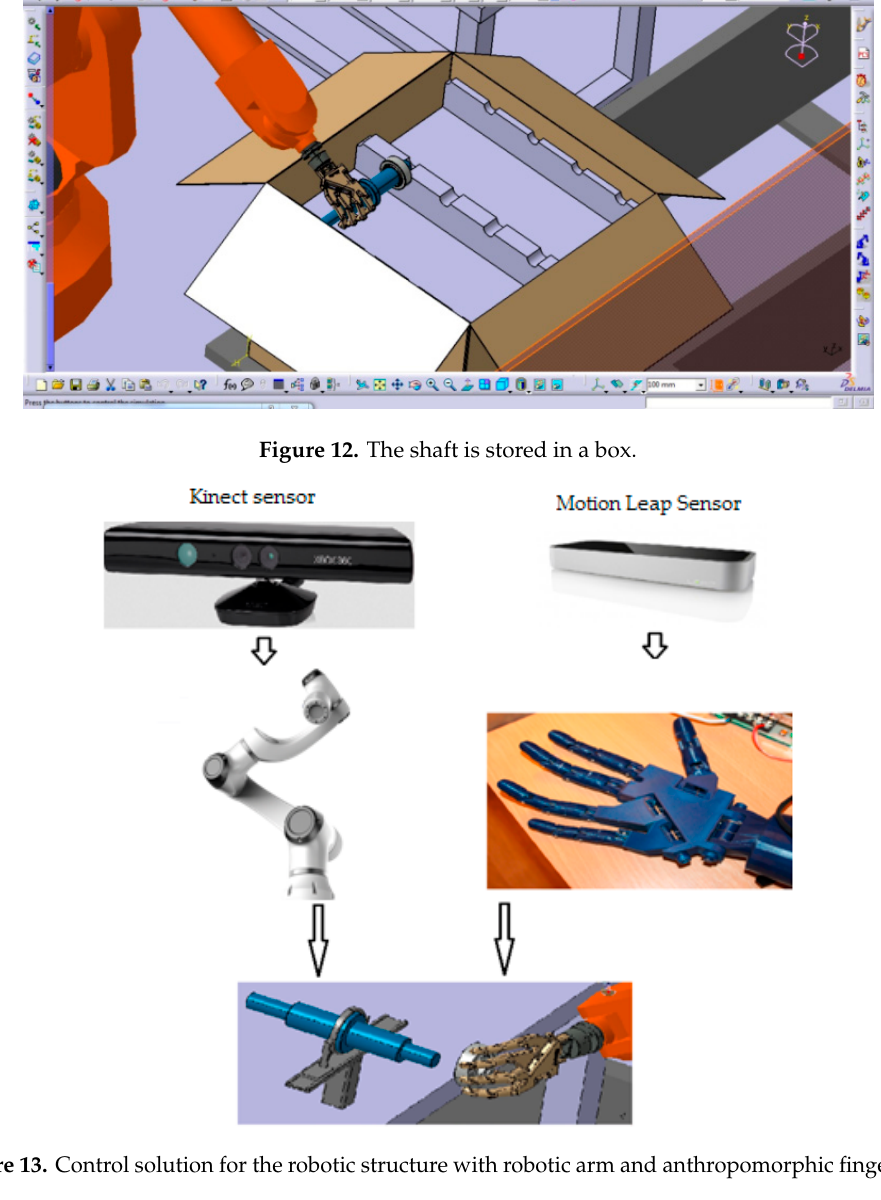
Figure 13. Control solution for the robotic structure with robotic arm and anthropomorphic finger grip.